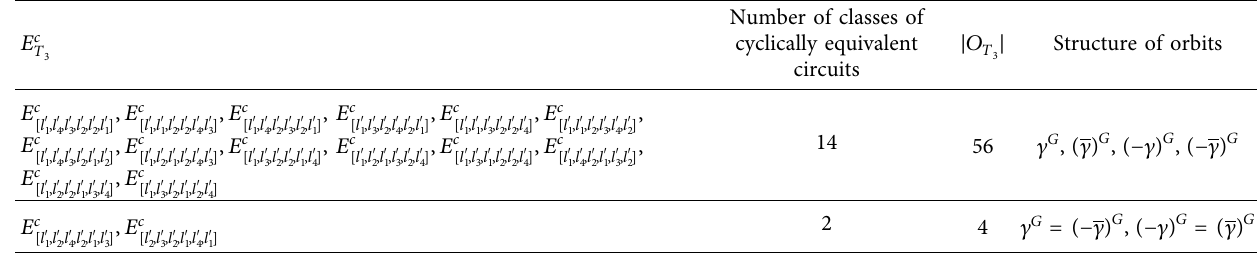
Table 10: Cyclically equivalent classes of T